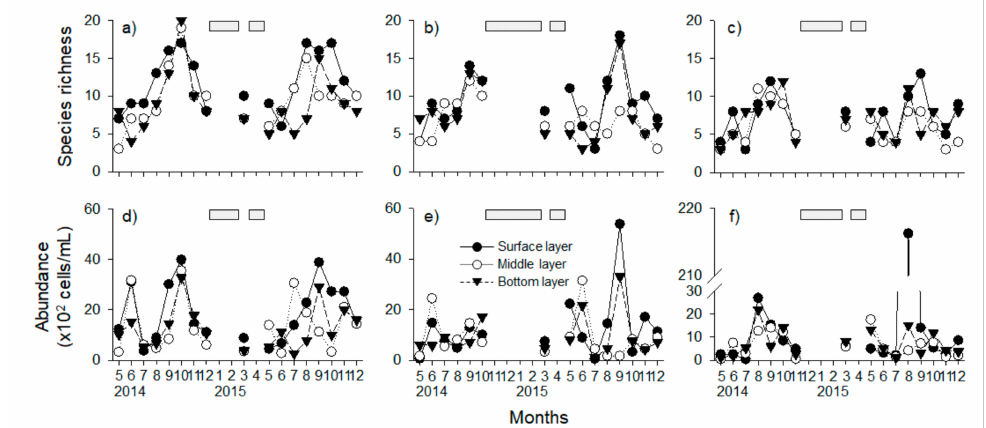
Figure 3. Temporal dynamics of the species richness and abundance of phytoplankton communities in three lakes—Uiam ( a , d ), Cheongpyeong ( b , e ), and Paldang ( c , f )—from May 2014 to December 2015. Gray bars indicate data loss/missing data due to freezing conditions or missing survey.